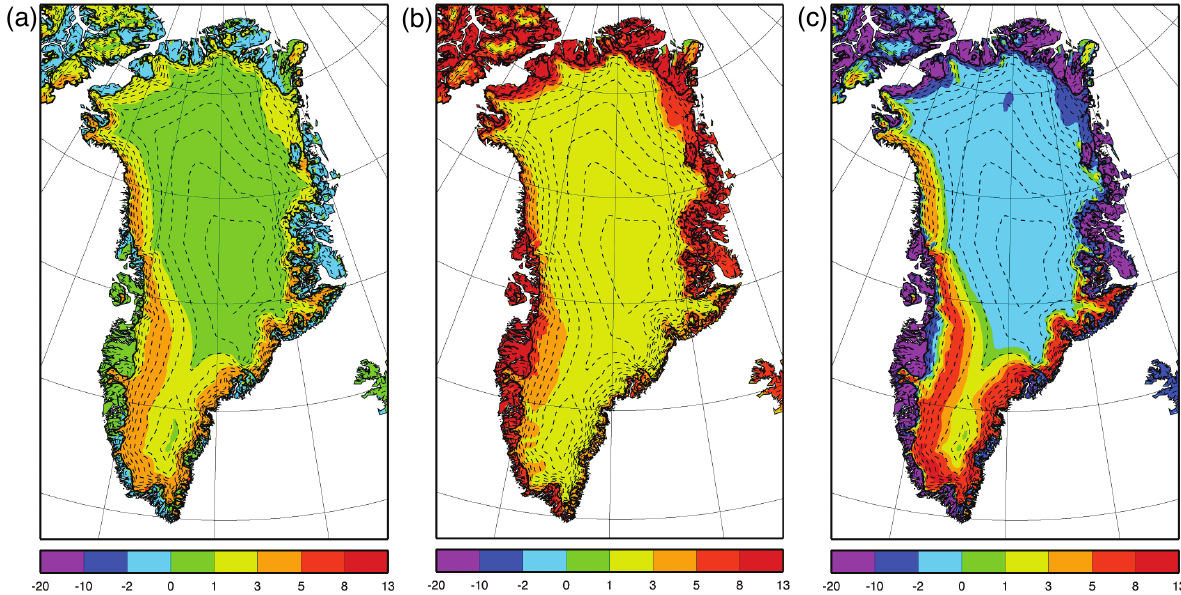
Fig. 15. Averaged subsurface heat flux G s [Wm − 2 ] over (a) a year, and the seasons (b) DJF and (c) JJA.